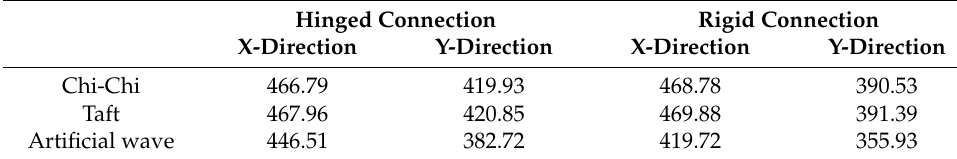
Table 9. Peak base shear under the action of frequent earthquakes (kN).